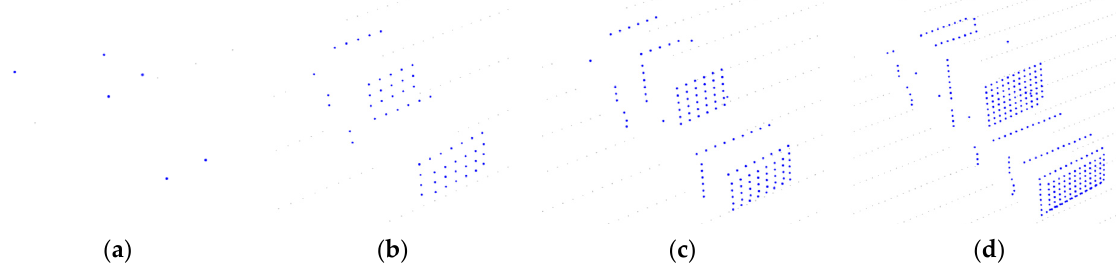
Figure 8. Vehicle point clouds under the same measurement angle with different sparseness. Blue points represent the target vehicle point cloud. ( a ) Point cloud with 𝑺 = 0.5 (6 points); ( b ) Point cloud with 𝑺 = 5 (59 points); ( c ) Point cloud with 𝑺 = 10 (126 points); ( d ) Point cloud with 𝑺 = 21 (274 points).